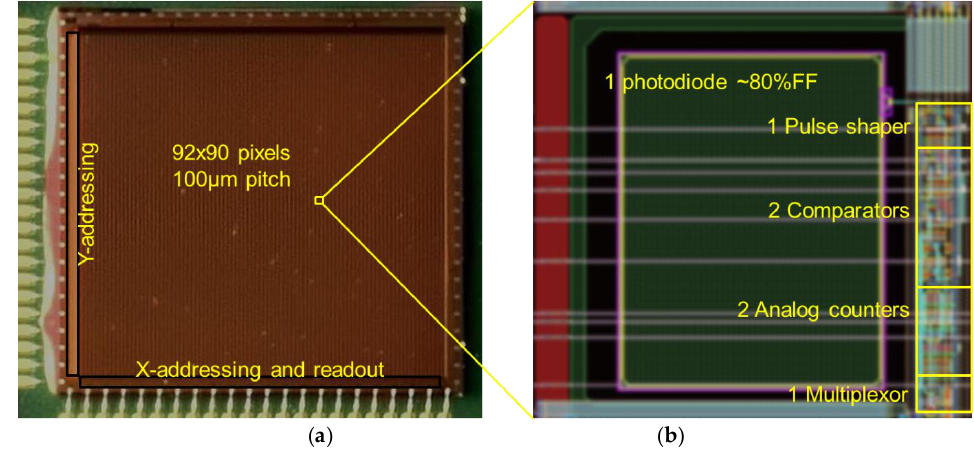
Figure 1. ( a ): microphotograph of the QX2010 device wire bonded on the CoB (chip on board); ( b ): Layout detail of one pixel, indicating the relative sizes and positions of the main pixels parts. Table 1. QX2010 image sensor specifications.